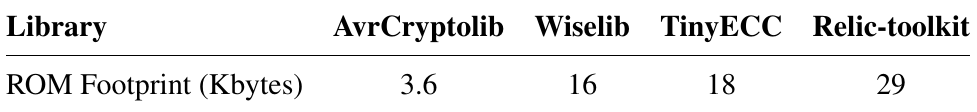
Table 5. Public-key encryption library ROM